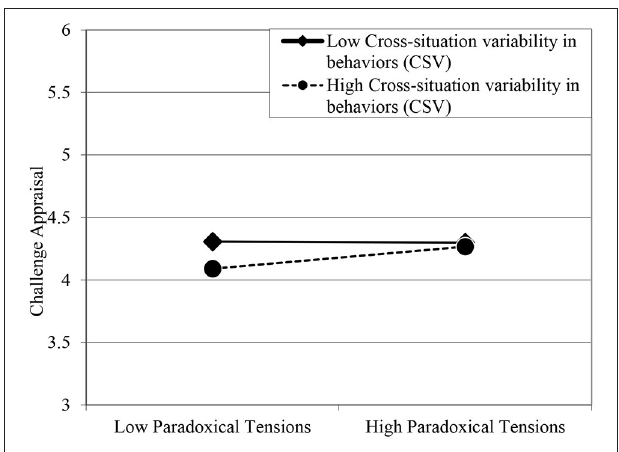
FIGURE 2 | Moderating effect of cross-situation variability in behaviors (CSV) on the relationship between paradoxical tensions and challenge